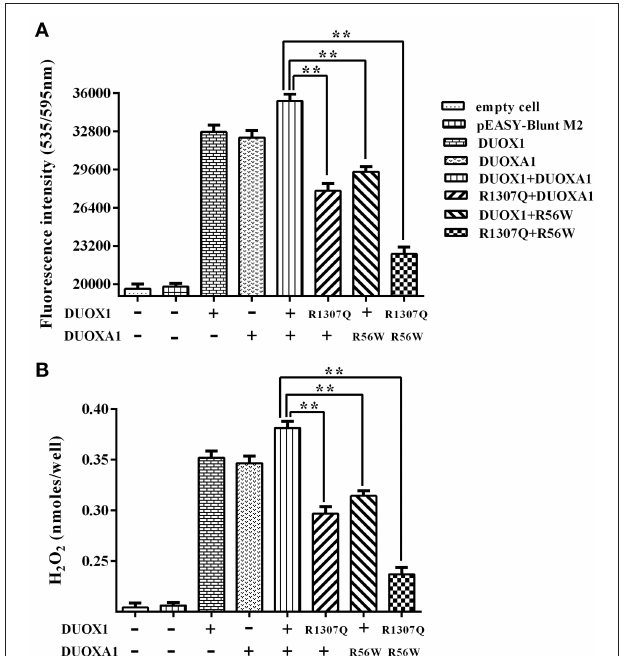
FIGURE 5 | H 2 O 2 generation in cells transfected with the indicated expression vectors. (A) Measurement of fluorescence intensity (535/595nm) under various indicated vector transfections. The group transfected with both wild-type DUOX1 and DUOXA1 had the maximum fluorescence intensity. (B) Presentation of the data in nanomoles of H 2 O 2 . The results were transformed from fluorescence intensity using a calibration curve. Each column represents the mean ± SD of three independent experiments performed in triplicate. ** P < 0.01.